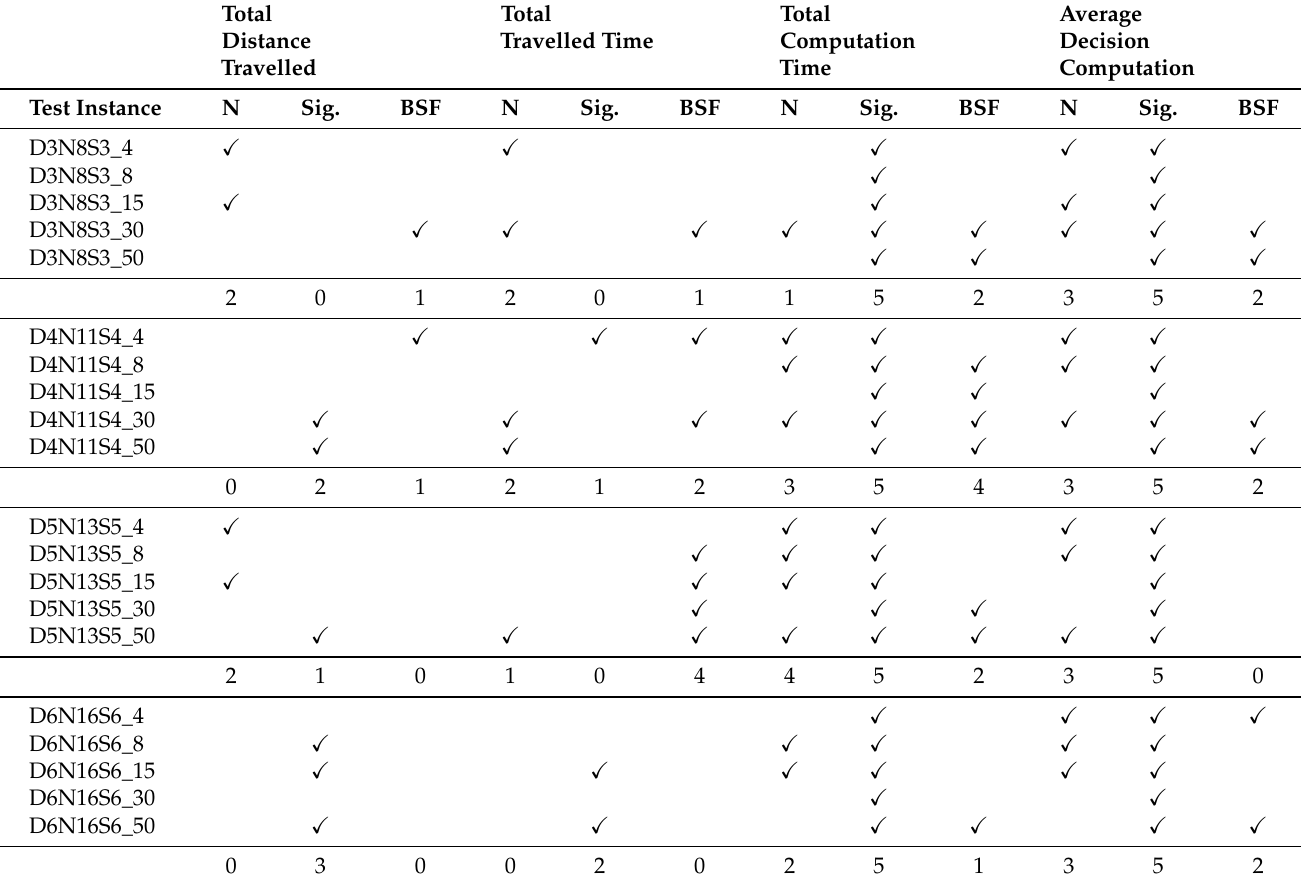
Table A5. PDS_RA performance with TBIH-4 application as base